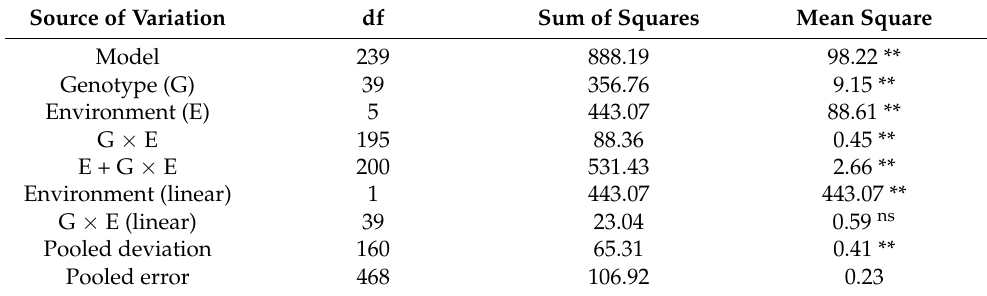
Pooled deviation